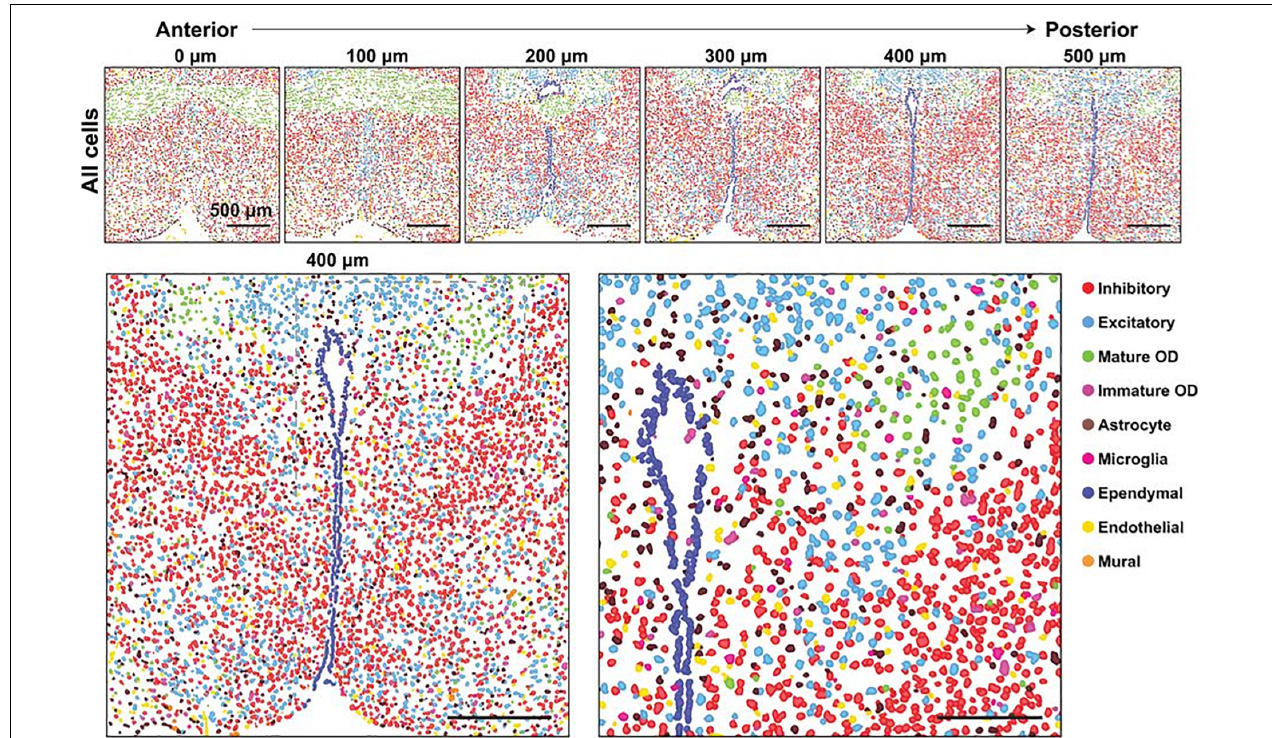
FIGURE 4 | Major cell classes and their spatial organizations in the POA as revealed with MERFISH. (Top) Spatial distribution of all major cell classes across sections at different anterior–posterior positions from a single female mouse. Cells are marked with cell segmentation boundaries and colored by cell classes as indicated. Six of the twelve 1.8- by 1.8-mm imaged slices are shown. The 0, 100, 200, 300, 400, and 500 mm labels indicate the distance from the anterior position (Bregma + 0.26). (Bottom) Enlarged image of the slice at 400 mm from the anterior position (left) and a further magnified image of the region shown in the gray dashed box (right). Scale bars, 500 mm (left), 250 mm (right). From Moffitt et al. (2018). Reprinted with permission from